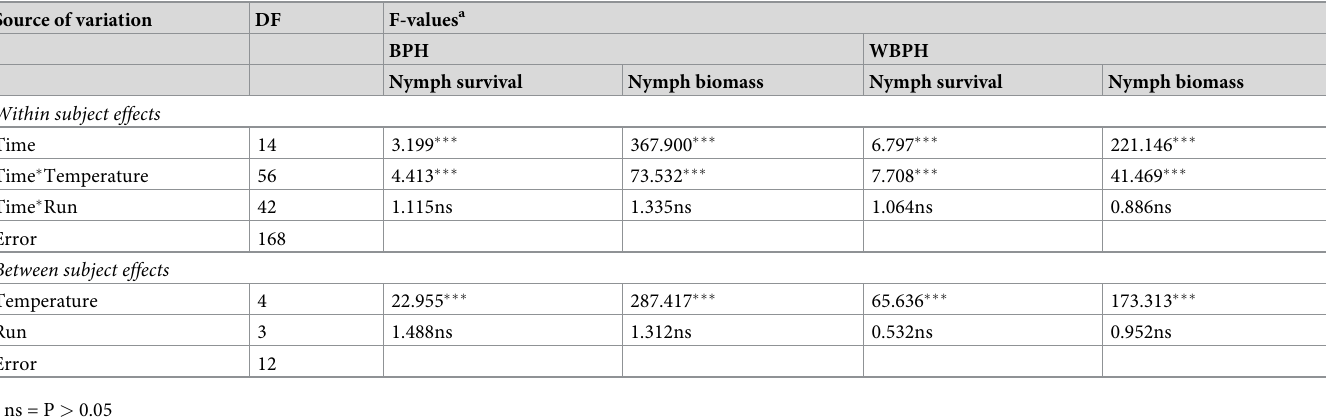
Table 4. Results of repeated measures GLMs of nymph survival and biomass over 15 days (see Fig 5).